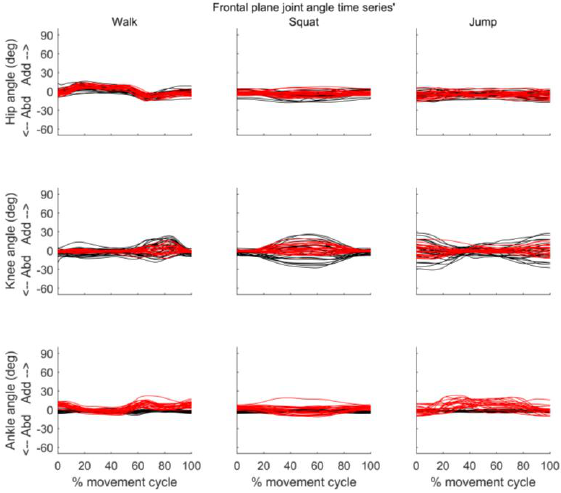
Figure 6. Frontal plane joint angles throughout the movement cycle for each participant. Time series of hip ( top row ), knee ( middle row ) and ankle ( bottom row ) joint angles obtained from VICON (black) and MVN BIOMECH (red) systems for each participant during walk ( left ), squat ( centre ), and jump ( right ). Y-axis represents joint angles in degrees and X-axis represent the movement cycle in percentage. Y-axis scale is the same as in Figure 5 to allow comparison.